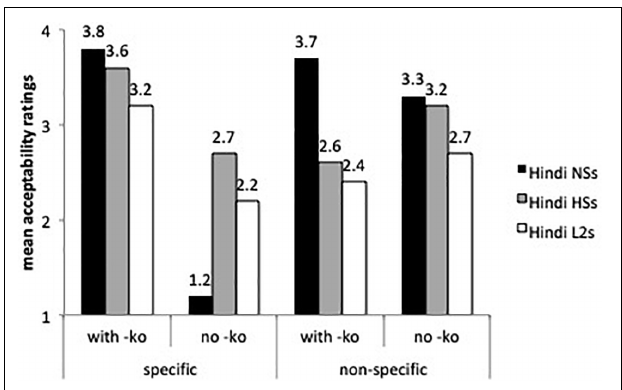
FIGURE 4 | Mean acceptability on - ko marking with animate, specific direct